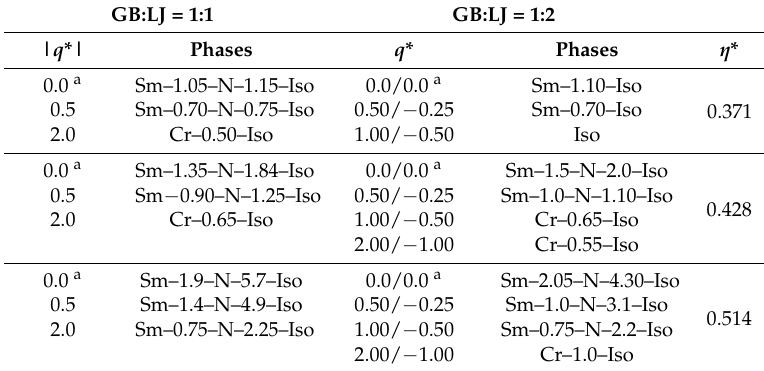
Table 2. Systems investigated in this work.